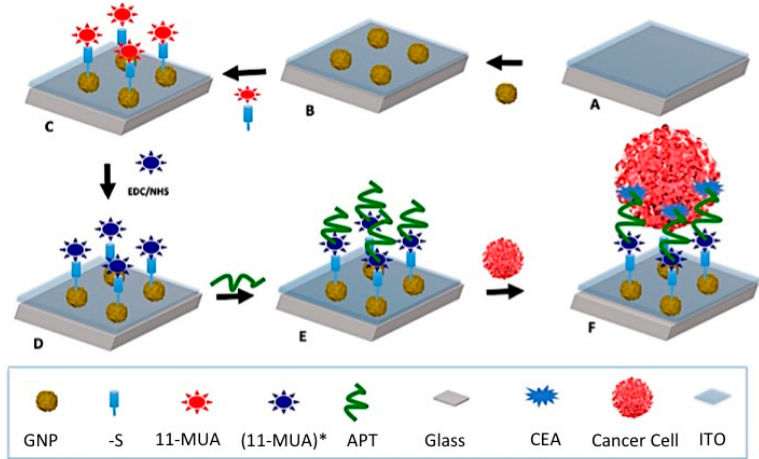
Figure 1. Illustration of the apta-DS fabrication process: ( A ) ITO coated glass; ( B ) Electrodeposited GNPs on ITO substrate (Working electrode); ( C ) Deposition of 11-MUA on GNPs; ( D ) Activation of 11-MUA using EDC/NHS; ( E ) Bonding of aptamer and activated 11-MUA [or so called (11-MUA) *] and ( F ) cancer cell attachment on aptamer.